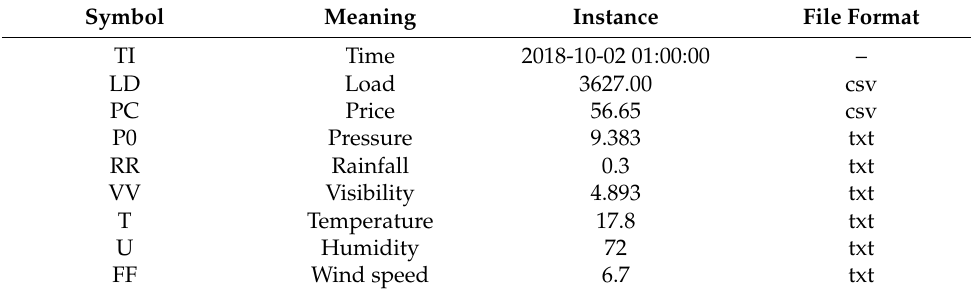
Table 1. Definition of the German dataset.